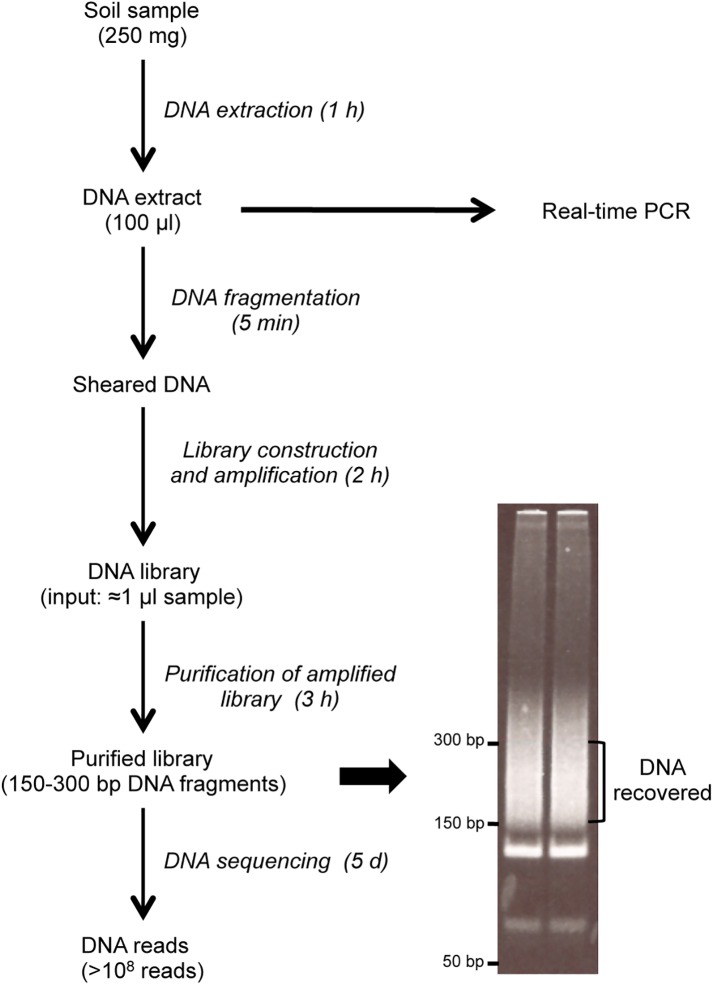
Schematic of the experimental workflow for metagenomic and PCR analysis of soil samples.